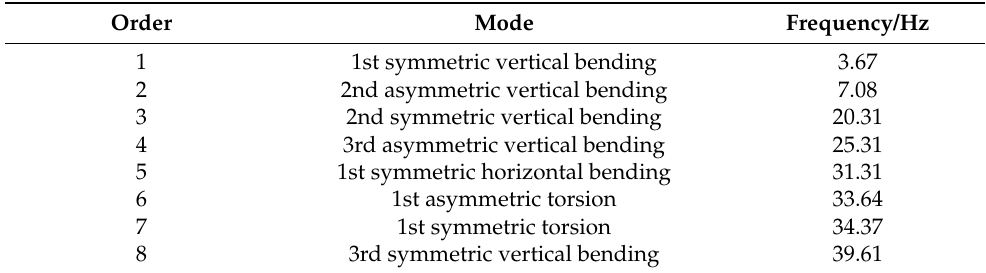
Table 2. Elastic modes analysis results.